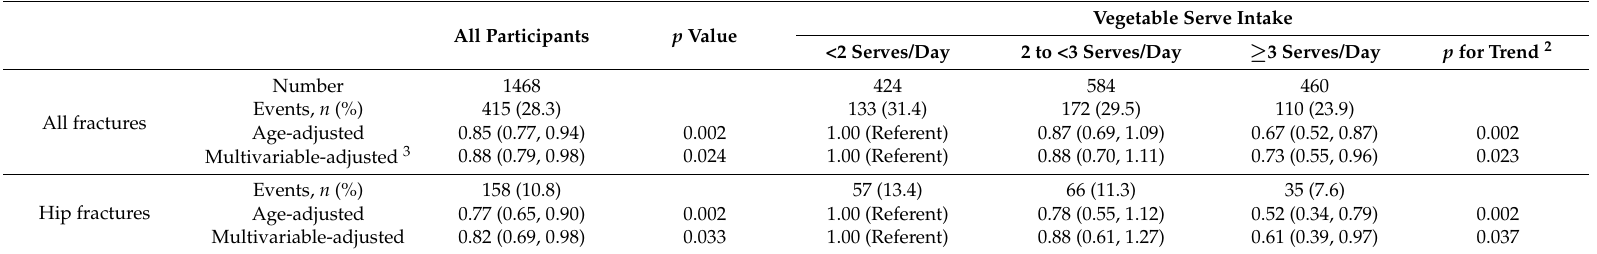
Table 3. Hazard ratios for fracture-related hospitalisation by vegetable serve intake 1 .